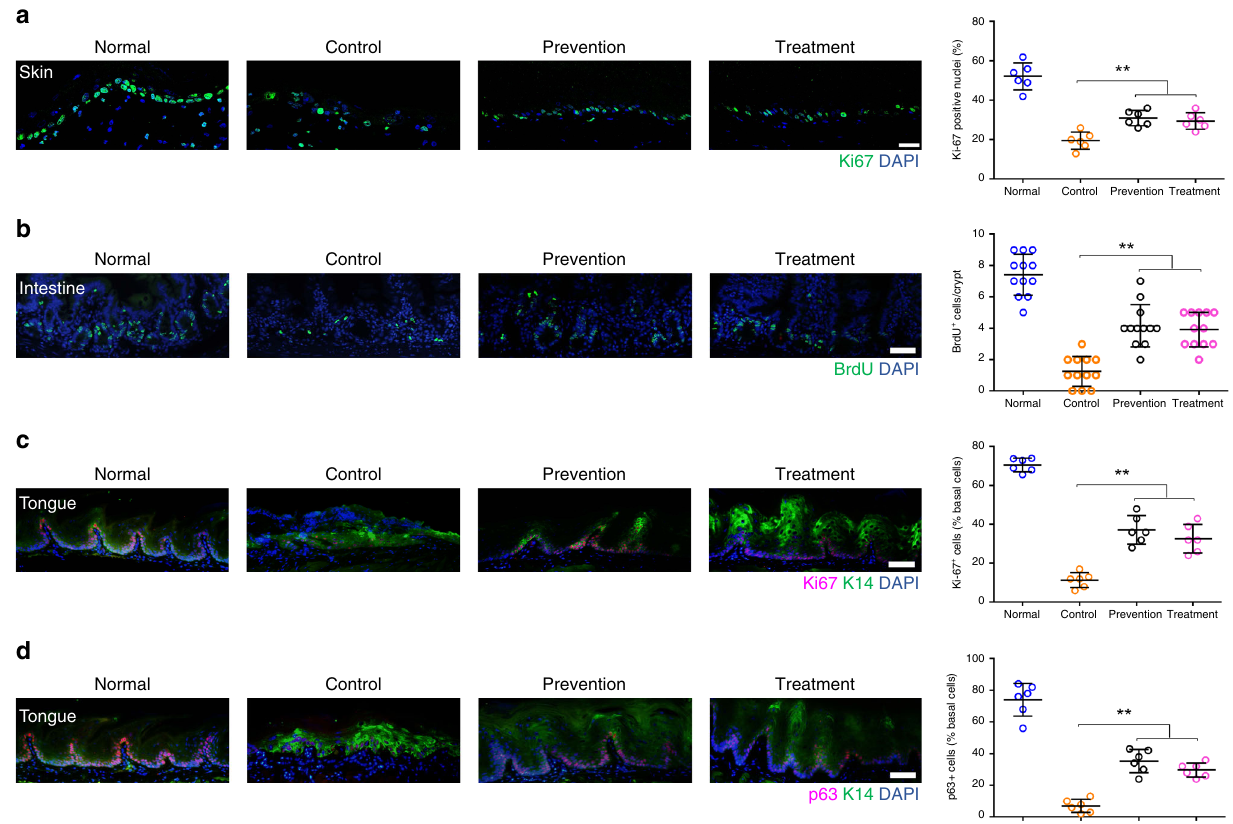
Fig. 5 Cordycepin prevents the loss of proliferation in vivo. a Representative confocal pictures and quantitation of Ki-67 in skin sections from normal rats and irradiated rats (control, prevention, treatment) 35 days after irradiation ( n = 6). b Representative immuno fl uorescence pictures and quantitation of BrdU in intestine sections from normal mice and irradiated mice (control, prevention, treatment) 4 days after irradiation. The BrdU positive nuclei was calculated using Image J software ( n = 12). c , d Representative immuno fl uorescence pictures and quantitation of Ki67 + and p63 + cells (% basal cells) in tongue sections from normal mice and irradiated mice (control, prevention, treatment) 10 days after irradiation, basal progenitor marker cytokeratin 14 (K14) was used to label the basal progenitor layer of tongue ( n = 6). The Ki-67 and p63 positive nuclei was calculated using Image J software. Bars represent 25 μ m ( a ), 50 μ m ( b – d ). Data in a – d represent the means ± S.D. (** P < 0.01; student ’ s t